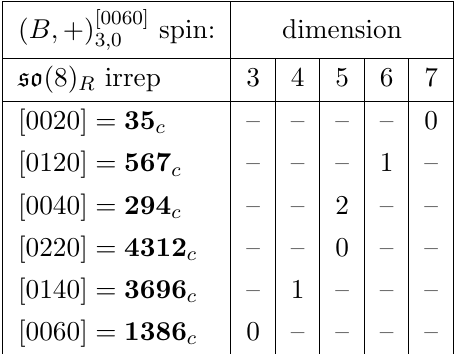
Table 21 . All possible conformal primaries in S 3 (cid:2) S 3 corresponding to the ( B; +) [0060] formal